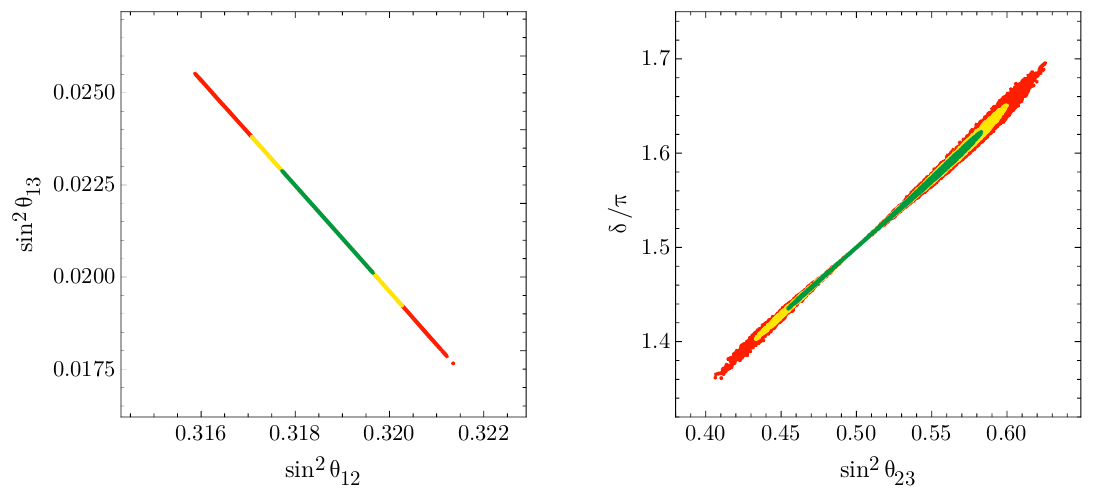
Figure 3. Correlations between sin 2 (cid:18) 12 and sin 2 (cid:18) 13 (left) and between sin 2 (cid:18) 23 and (cid:14) (right) in a model with residual